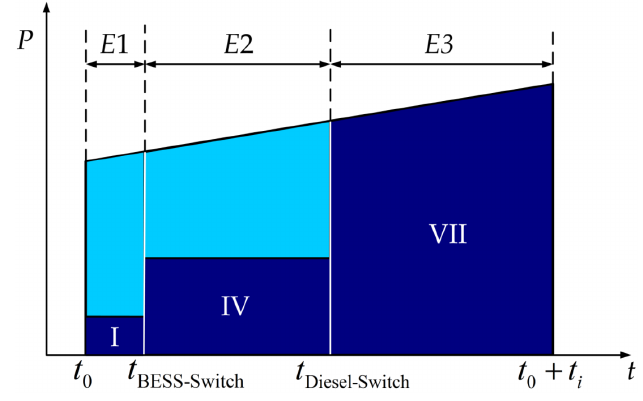
Figure 11. Compensated energy shortage ( ACR = 0).